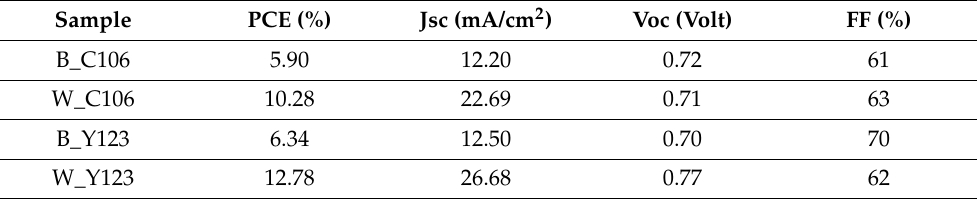
Figure 5. J–V of C106 and Y123 devices (TiO 2 film thickness of 11.6 µm) on white and black background . Table 2. Electrical parameters of J–V curves of C106 and Y123 devices (TiO 2 film thickness of 11.6 µm) on white and black background .